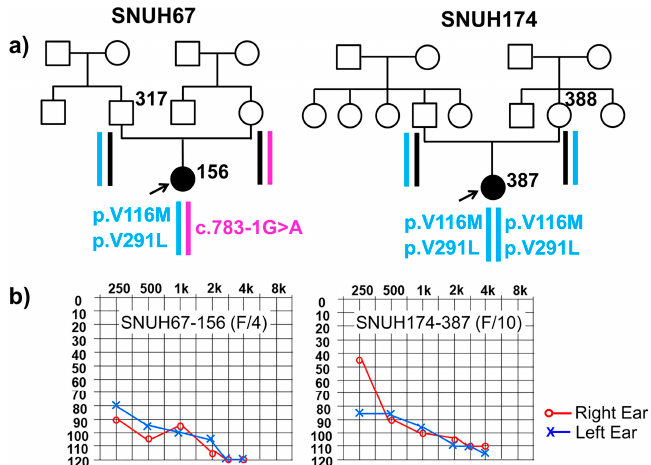
Figure 1. Pedigrees of the two families related to TMPRSS3 and audiograms of affected subjects. ( a ) In this pedigree, the most likely haplotype of TMPRSS3 is reconstructed based on the segregation study. The p.[p.V116M; p.V291L] allele (grey box) is shared by the two unrelated probands (red arrow). ( b ) Pure tone audiometry obtained from both probands directly before cochlear implantation is presented. Severe-to-profound hearing loss with minimal residual hearing is shown. Red colored graph refers to left-sided hearing loss and blue colored graph refers to right-sided hearing loss.